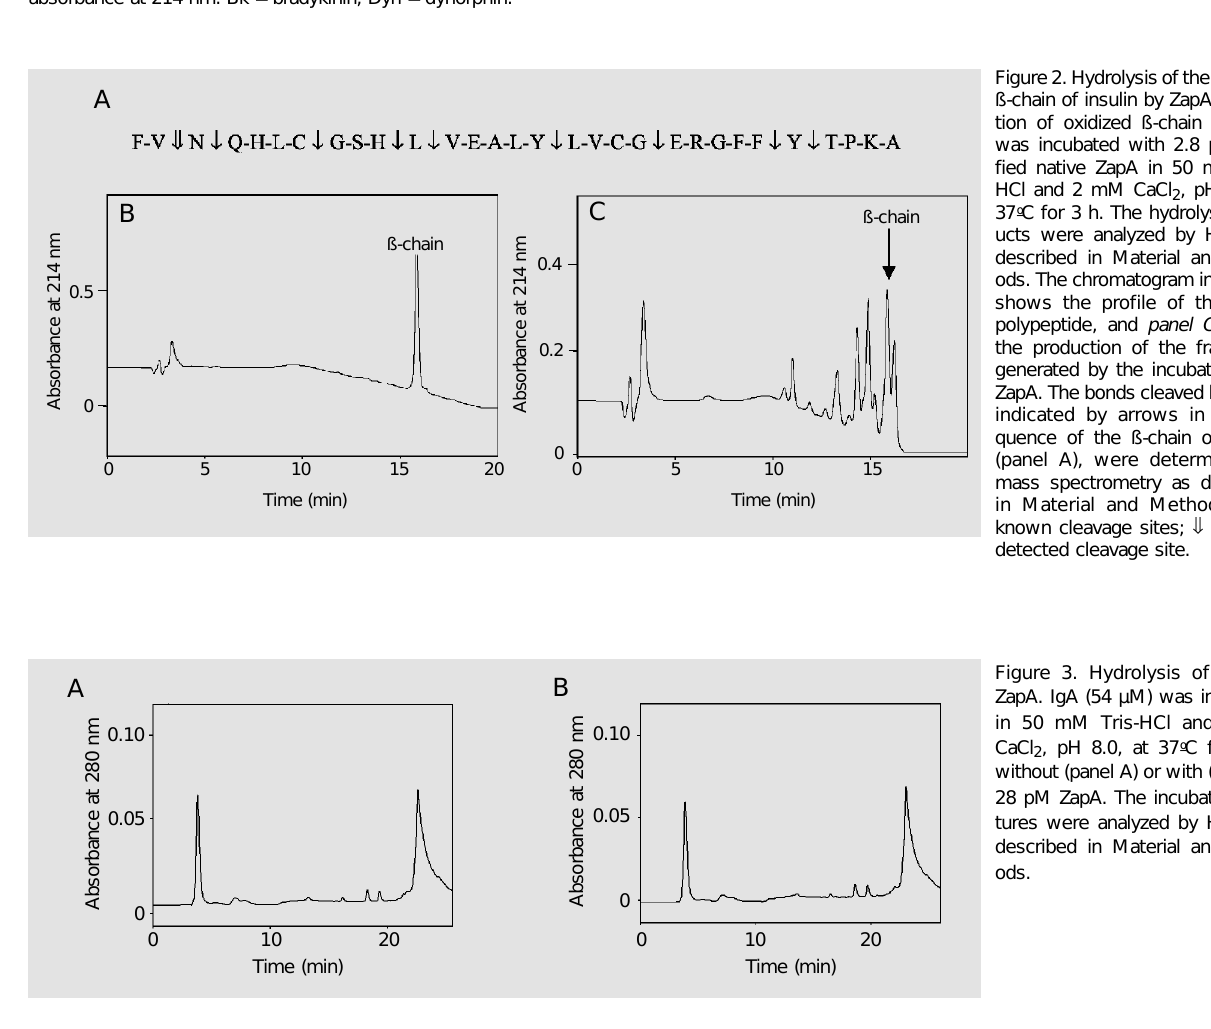
Figure 1. Hydrolysis of the fluorogenic peptides 1 and 2 by ZapA. Solutions of peptide 1 (Abz-R-P-P-G-F-S-P-F-R-EDDnp) and of peptide 2 (Abz-G-G-F-L- R-R-Q-EDDnp) were incubated with 2.8 pM purified native ZapA in 50 mM Tris-HCl and 2 mM CaCl 2 , pH 8.0, at 37 º C for 3 h. The hydrolysis products were analyzed by HPLC as described in Material and Methods. The chromatograms in panels A and B show the elution profiles of the fragments generated by the incubation of peptide 1 and peptide 2 with ZapA, respectively. Dashed lines indicate fluorescence and continuous lines show the absorbance at 214 nm. Bk = bradykinin; Dyn = dynorphin.